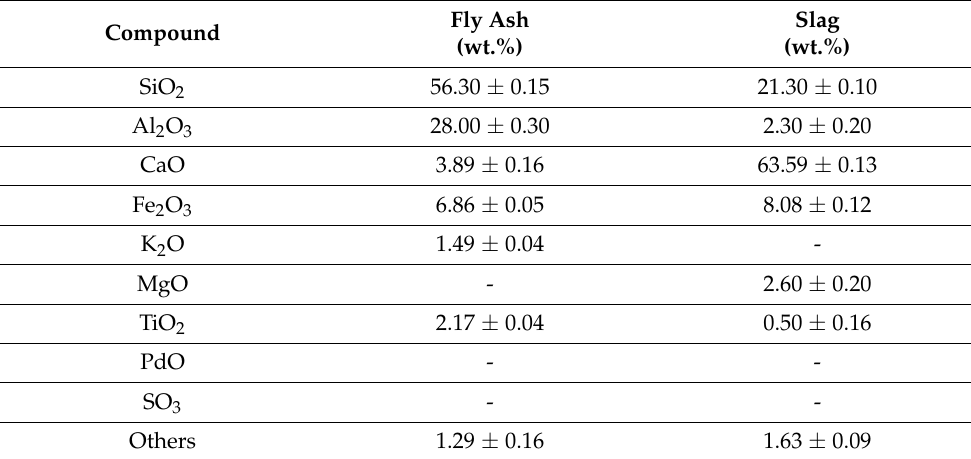
Table 1. Chemical composition of fly ash and slag.